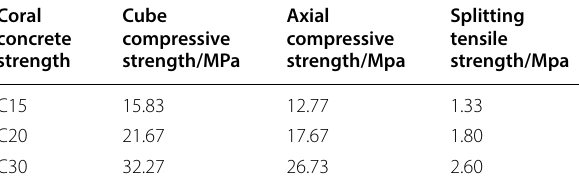
Table 5 Basic mechanical property of coral concrete. Coral concrete